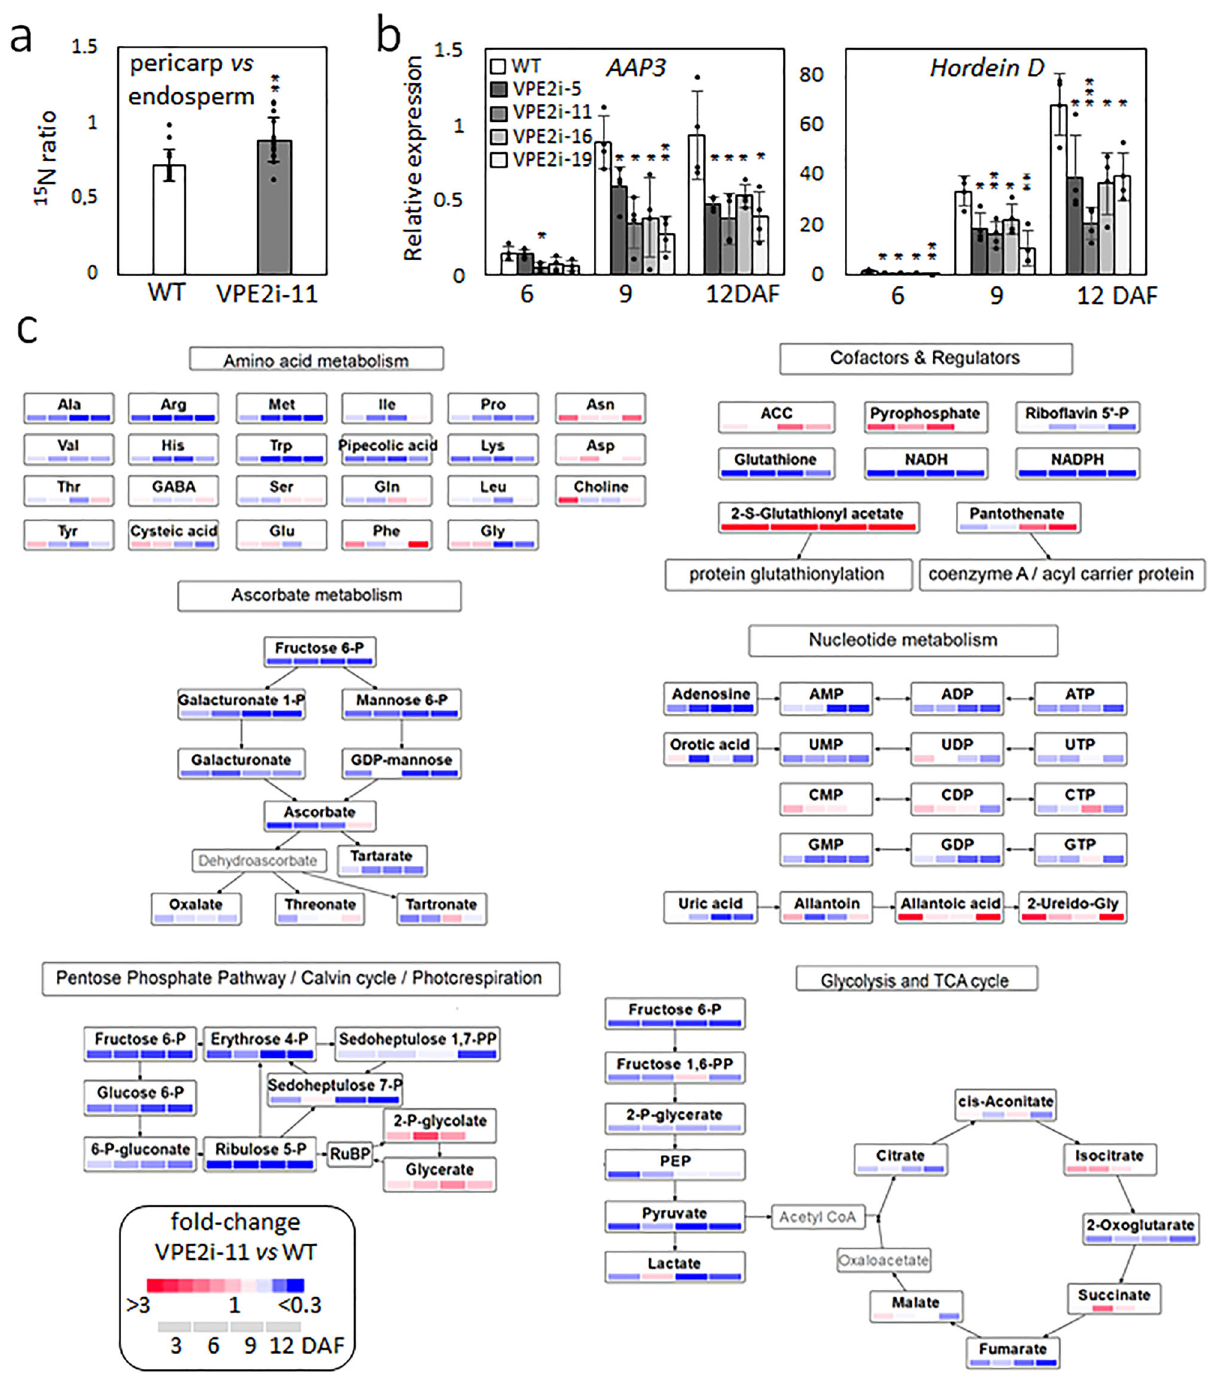
Fig. 7 The metabolic effect of suppressing VPE2 subfamily. a The ratio of 15 N accumulated in pericarp versus endosperm as indicator of differential nitrogen allocation within a grain (9 DAF). b The abundances of transcripts generated from genes encoding amino-acid permease 3 (AAP3) and hordein D. c A heat map illustrating the abundance of various amino acids, co-factors, and regulators, components of ascorbate and nucleotide metabolism, components of the pentose phosphate pathway, the Calvin cycle and photorespiration, and of glycolysis and the tricarboxylic acid cycle (TCA) measured using LC/MS in immature grains of the transgenic line VPE2i-11 versus WT. Concentrations indicated by color coding. Data are shown as the mean ± SD ( n = 15 in a , = 4 in b , = 8 in c ). *, **, ***: means differ at P < 0.05, < 0.01, and < 0.001, respectively. Abbreviations: DAF days after fl owering, WT wild